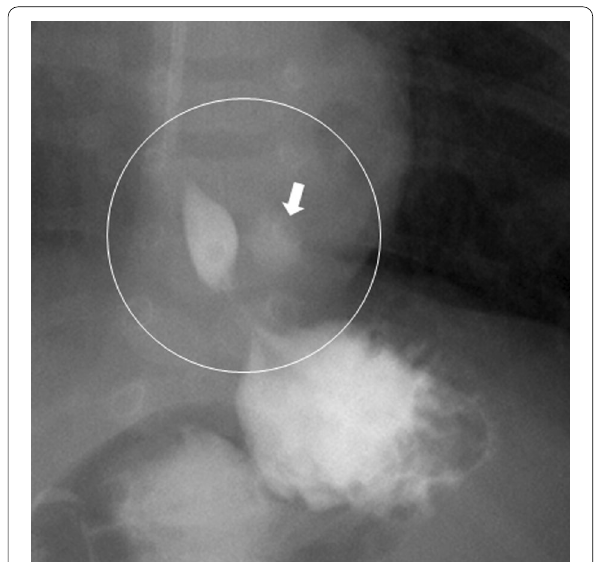
Fig. 2 Esophagogastric cotrast study. The esophagogastric cotrast study revealed a faint contrast structure (arrow) just above the left diaphragm and in contact with the